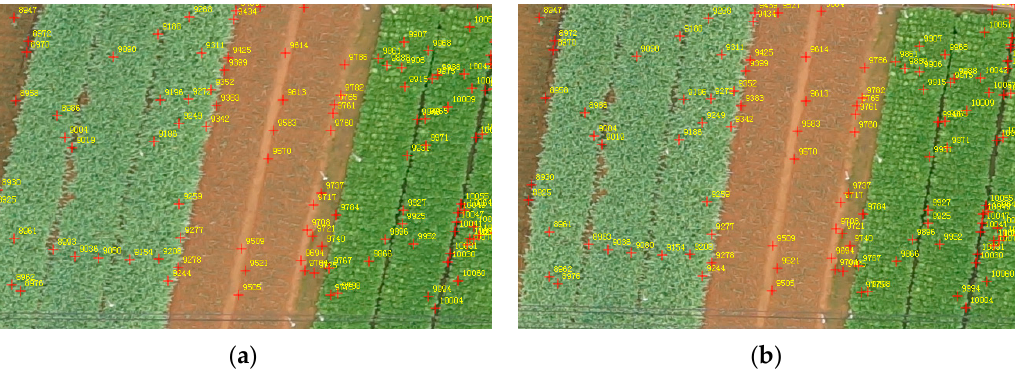
Figure 9. Tie-point extraction of two images. Correspondences are linked by identical numbers: (a) tie-points of the first image and (b) tie-points of the second image.